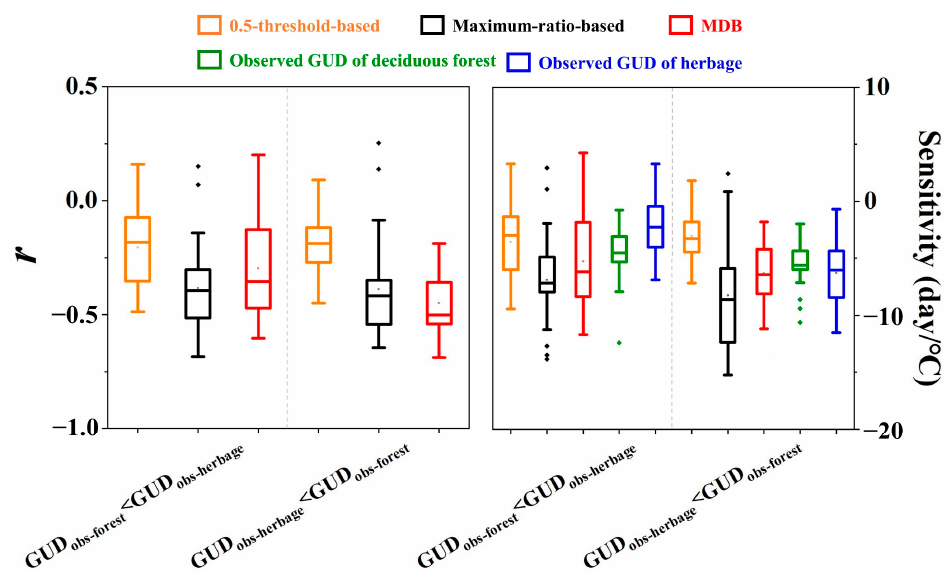
Figure 9. Sensitivity of estimated green-up date (GUD est ) derived from three predictive methods (0.5-threshold-based method, Maximum-ratio-based method, Maximum-derivative-based (MDB) method), and ground observed GUD (GUD obs ) of deciduous forest and herbage to annual mean temperature in the forest-herbage-mixed (FHM) sites with GUD obs-forest < GUD obs-herbage and with GUD obs-herbage < GUD obs-forest .